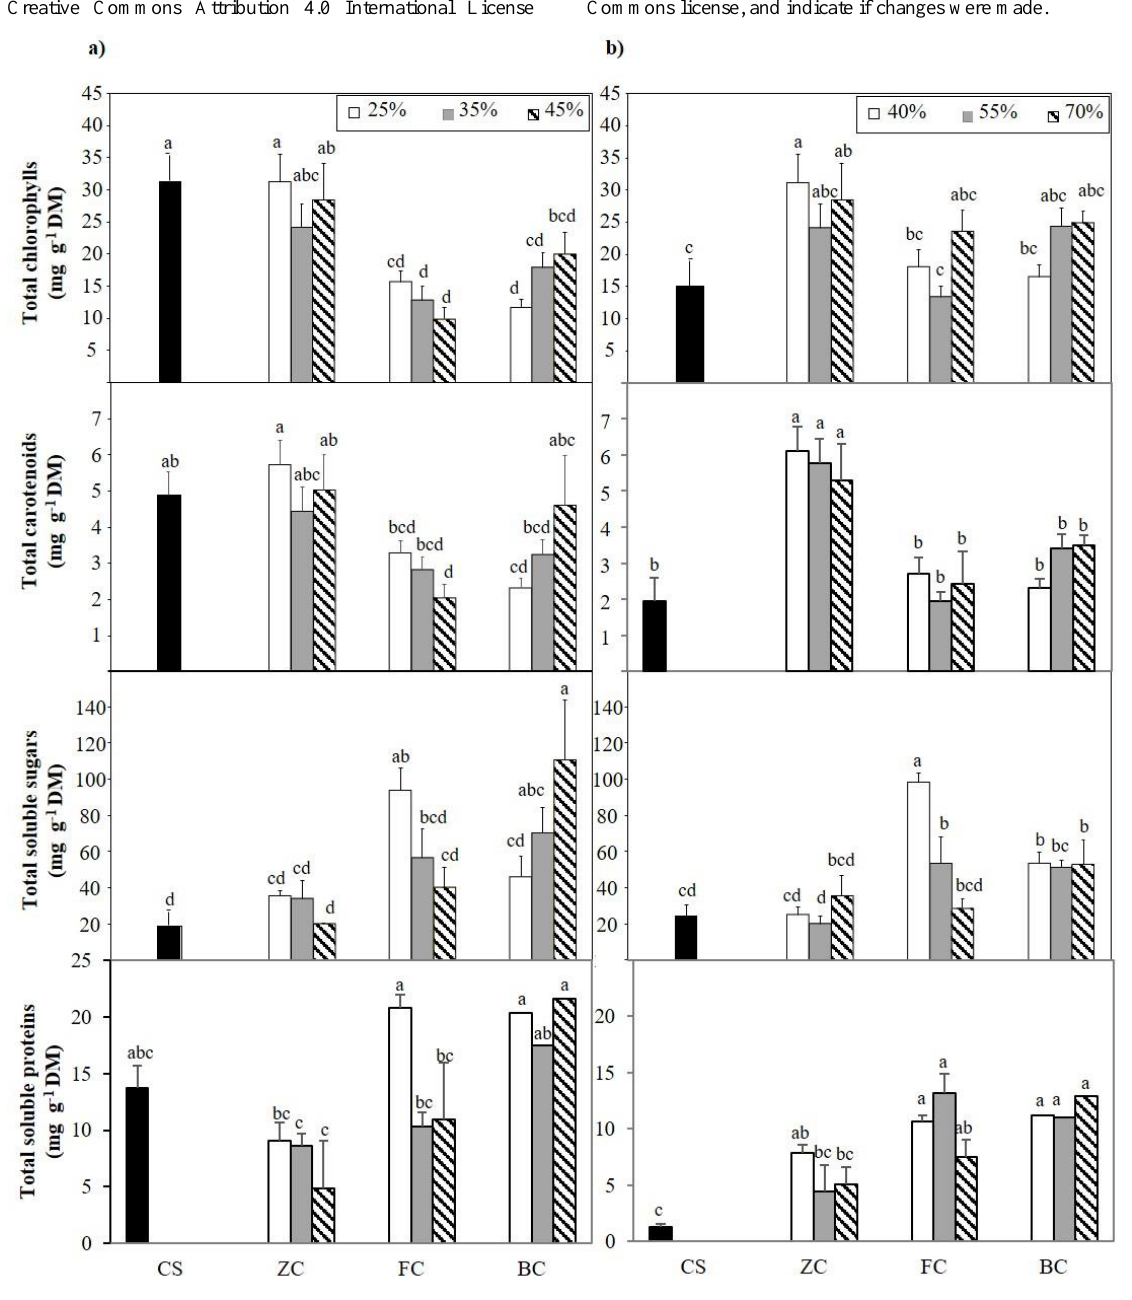
Fig. 3 Leaf pigments and primary metabolites from a) pepper and b) tomato seedlings grown in perlite amended with different doses of compost Carrot compost (ZC), fat compost (FC) and biosolids compost (BC). A commercial substrate (CS) was used as a control treatment. Values are means± S.E. (n=9). Bars topped by the same letter do not differ significantly (P≥0.05) according to Duncan’s